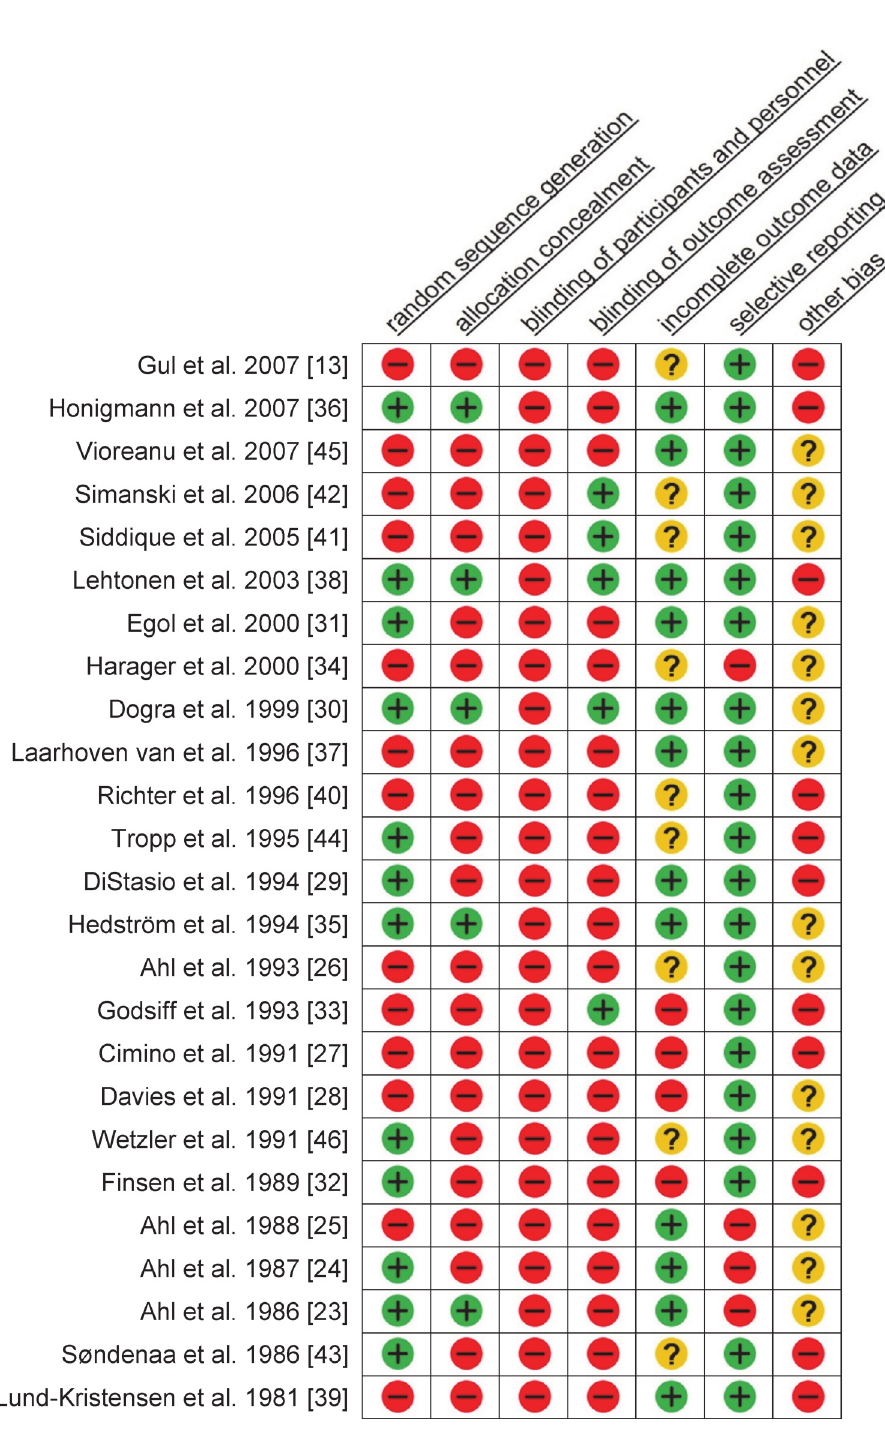
Fig 2. Risk of bias assessment. — indicates a high risk of bias; + indicates a low risk of bias;? indicates an unclear risk of bias.